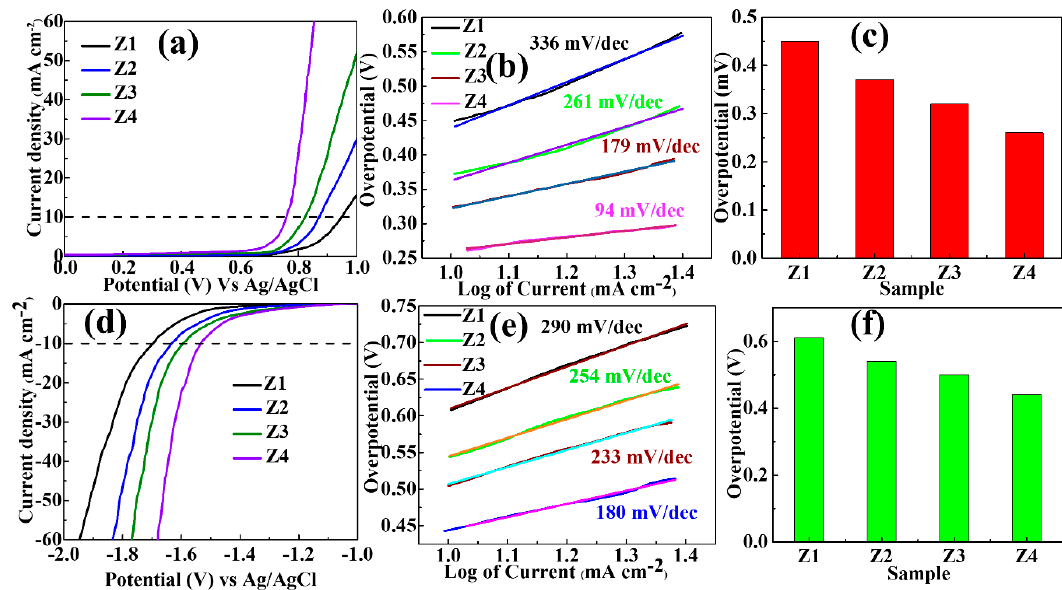
Figure 9. ( a )–( c ) show the linear sweep voltammogram (LSV), Tafel plots and overpotential for oxygen evolution reaction (OER) for synthesized ZnO dried at 80 °C; ( d )–( f ) show the LSV, Tafel plots and overpotential for hydrogen evolution reaction (HER) for synthesized ZnO dried at 80 °C.